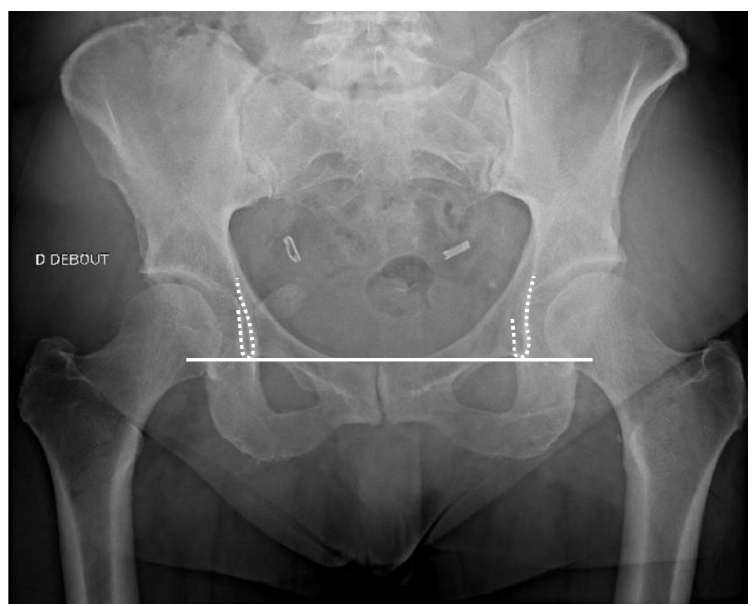
Figure 5. Inter ‐ teardrop axis. The inter ‐ teardrop axis shown on an anteroposterior pelvic radiograph Figure 5. Inter-teardrop axis. The inter-teardrop axis shown on an anteroposterior pelvic radiograph (white line), the teardrops being represented by the dotted lines. (white line), the teardrops being represented by the dotted